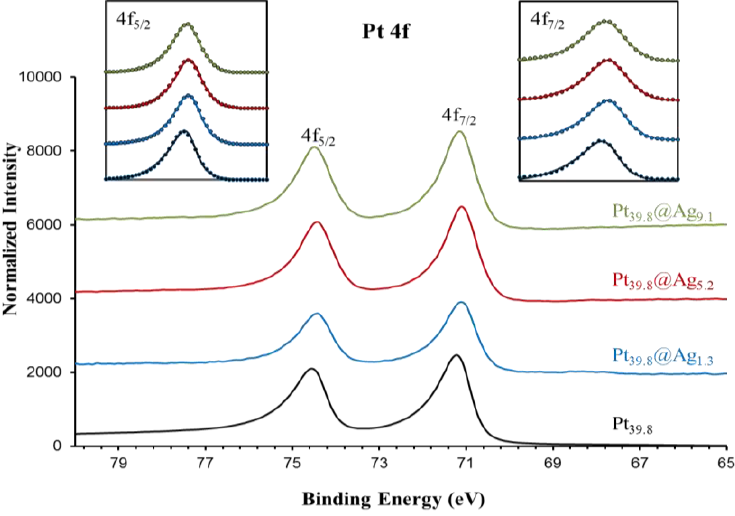
Figure 8. XPS spectra for platinum core particle (39.8 nm) ( A ) and Pt with an optimal silver shell thickness of 1.3 ( B ); 5.2 ( C ); and 9.1 ( D ) nm. The inserted graphs show the Pt 4f and 4f peaks (solid curves) and the fitting with the asymmetric 7/2 5/2 G-L mixed function